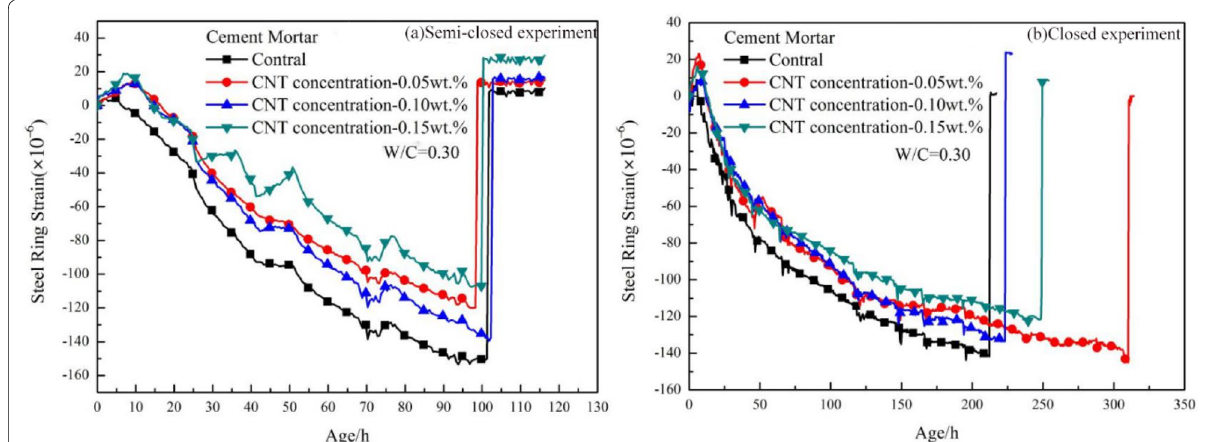
Fig. 6 Cracking strain curve of cement mortar with CNTs (W/C